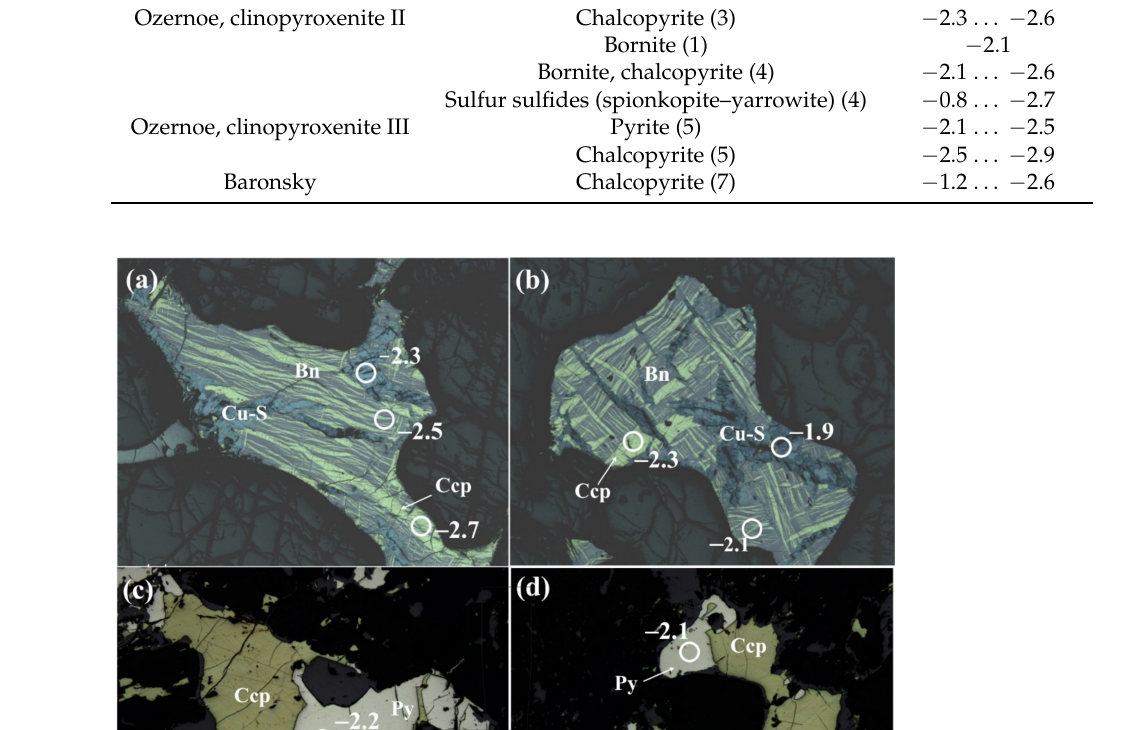
Table 11. Isotopic composition of sulfur ( δ 34 S) sulfides from the Ozernoe and Baronsky deposits. Deposit